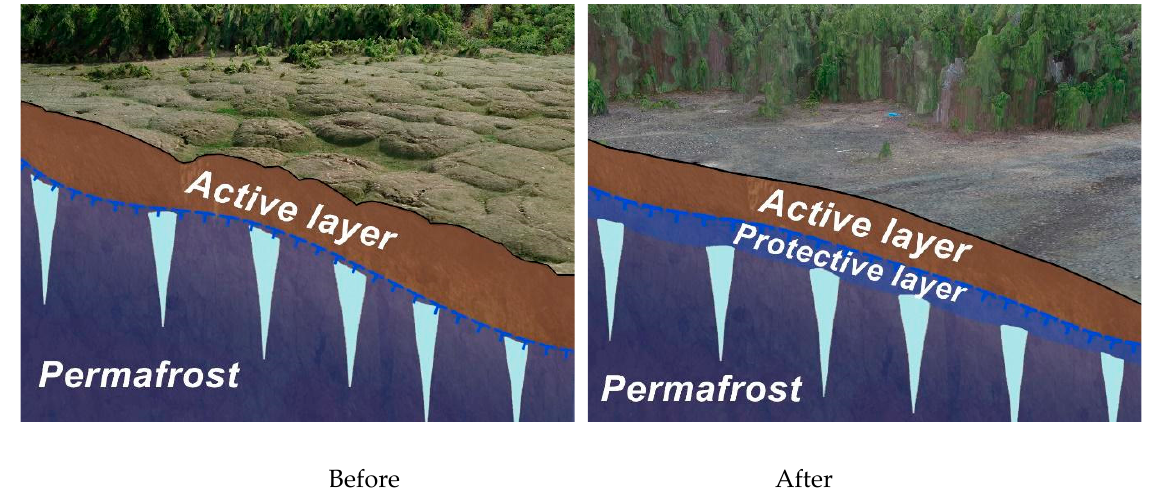
Before After Figure 3. Schematic of thermokarst remediation by restoring the transition Figure 3. Schematic of thermokarst remediation by restoring the transition layer.